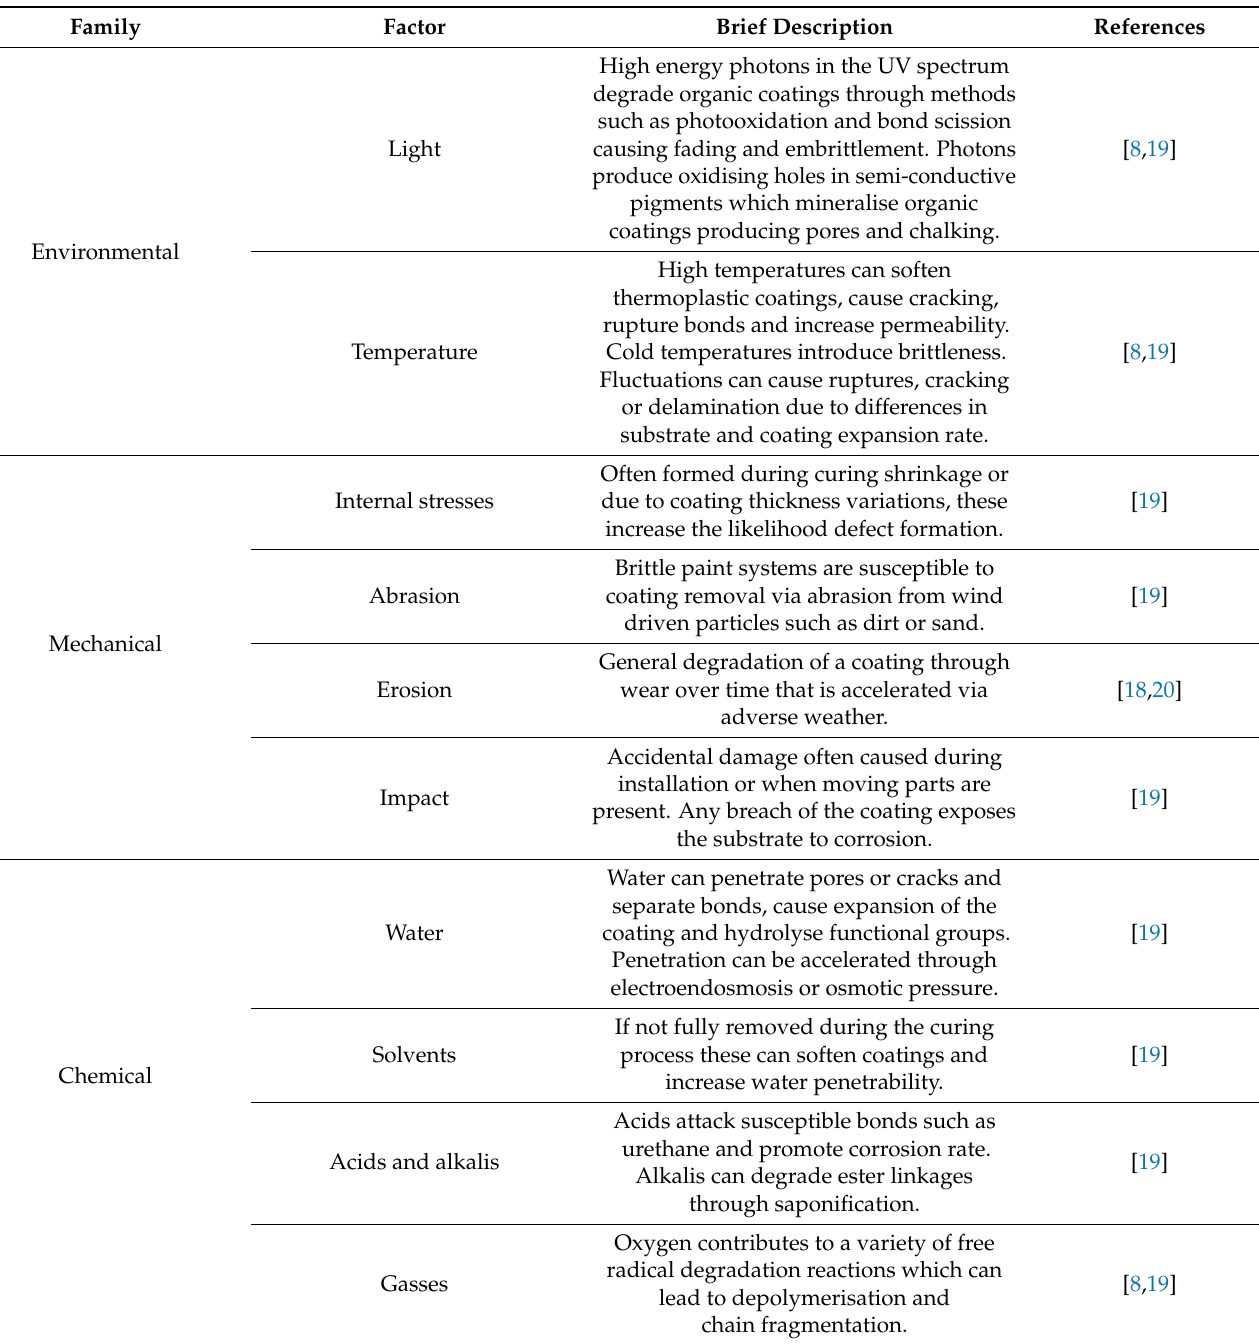
Table 3. Factors contributing to coating